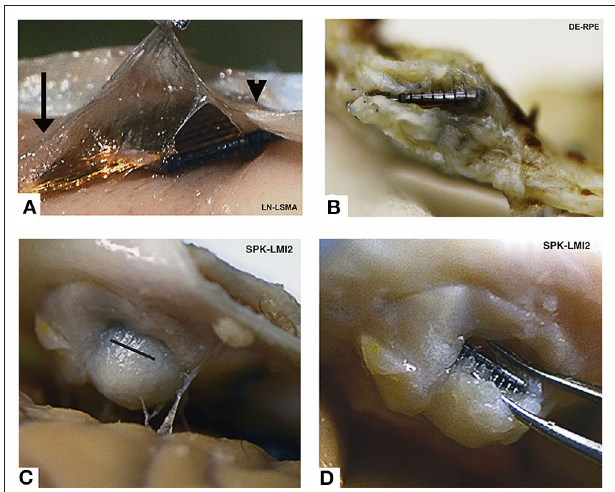
FIGURE 5 | Encapsulated arrays—gross specimens. All arrays show grossly visible encapsulation, however the extent of encapsulation varies greatly. (A) Thin tissue capsule with arachnoid appearance at 37 days post-implant. This tissue can be seen merging with normal arachnoid to the left (arrow) and normal dura to the right (arrowhead). (B) Dense fibrous tissue encapsulation at 761 days post-implant. The array is intradural in this photo. (C) Complete encapsulation by day 853. The capsule was cut open (black line) in order to visualize the array seen in (D) . Array names reflect monkey name and